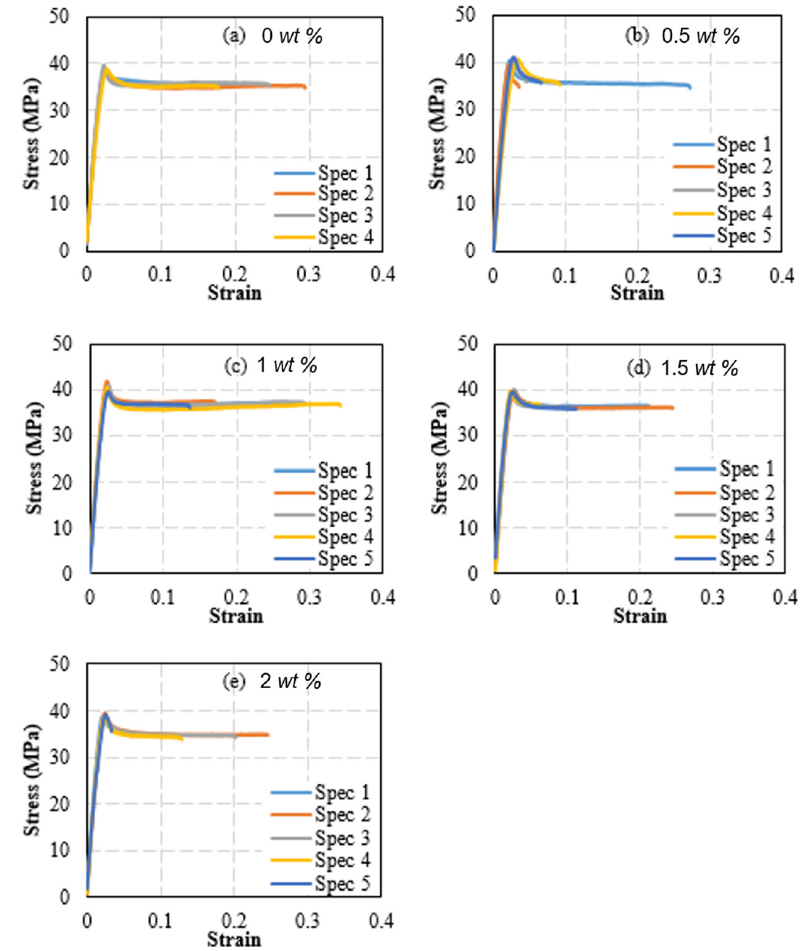
Figure 13. Stress-Strain curves of PLA filaments reinforced with silicon carbide. Subfigures ( a – e ) correspond to carbide weight fractions of 0%, 0.5%, 1%, 1.5%, and 2%, respectively.